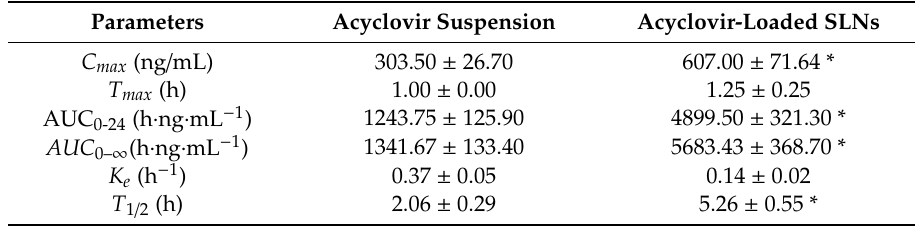
Table 5. Pharmacokinetic parameters after oral administration of acyclovir-loaded SLNs or commercial suspension. The data represent mean ± S.D. ( n =